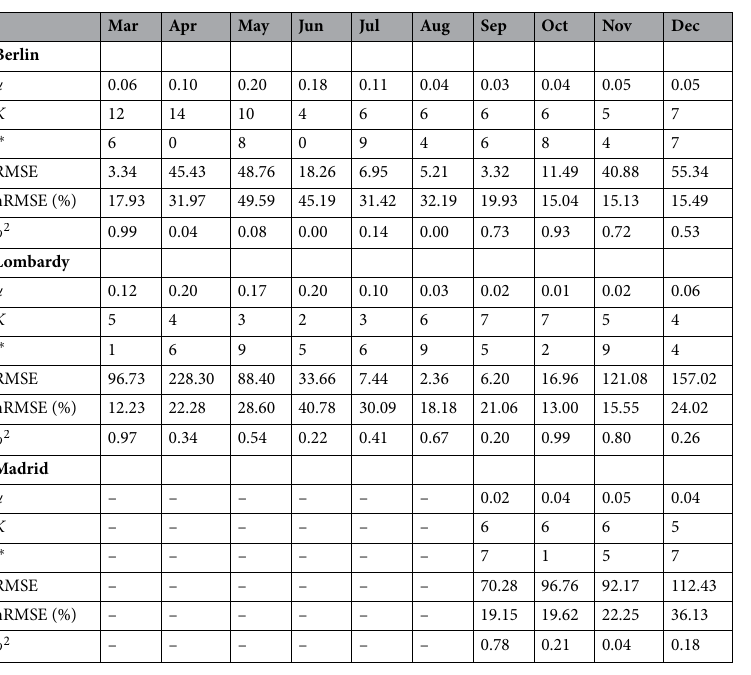
Table 2. Monthly estimates of ICU rate α , stay in ICU K , time lag between positive testing and entering the ICU l ∗ , as well as model fit in terms of RMSE, normalized RMSE (nRMSE), and squared correlation ρ extended